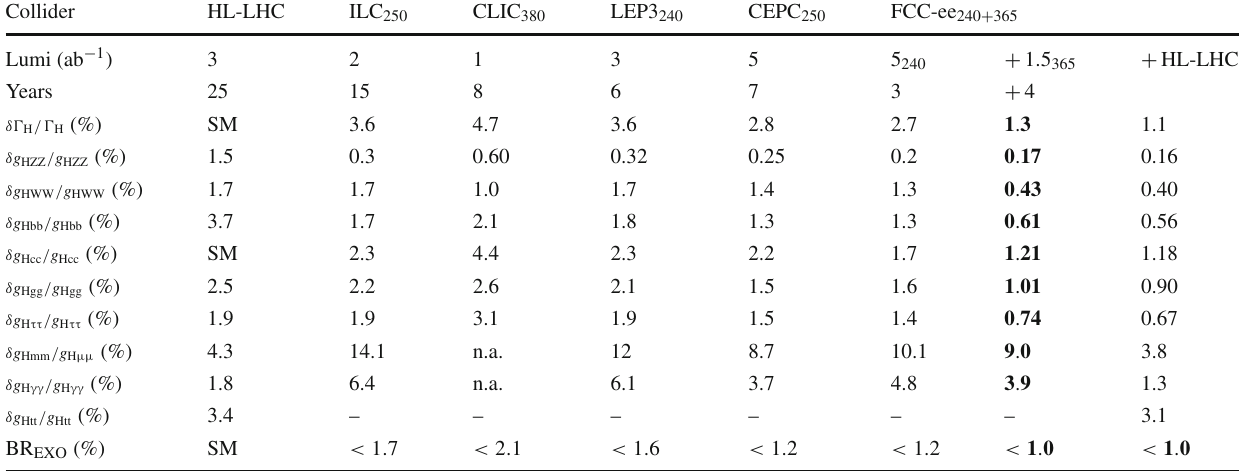
Table 4.2 Precision determined in the κ framework of the Higgs boson couplings and total decay width, as expected from the FCC-ee data, and compared to those from HL-LHC [18] and other e + e − colliders exploring the 240-to-380 GeV centre-of-mass energy range. All num- bers indicate 68% CL sensitivities, except for the last line which gives the 95% CL sensitivity on the “exotic” branching fraction, accounting for final states that cannot be tagged as SM decays. The FCC-ee accu- racies are subdivided in three categories: the first sub-column give the